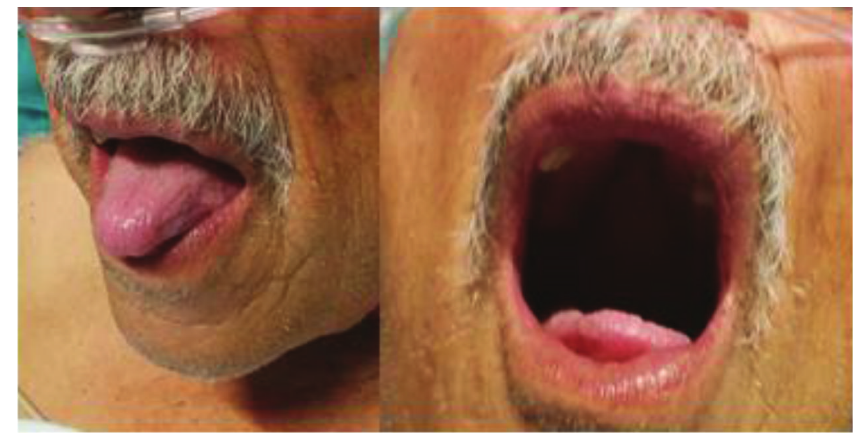
Figure 2: After 24 hours of ACE inhibitor